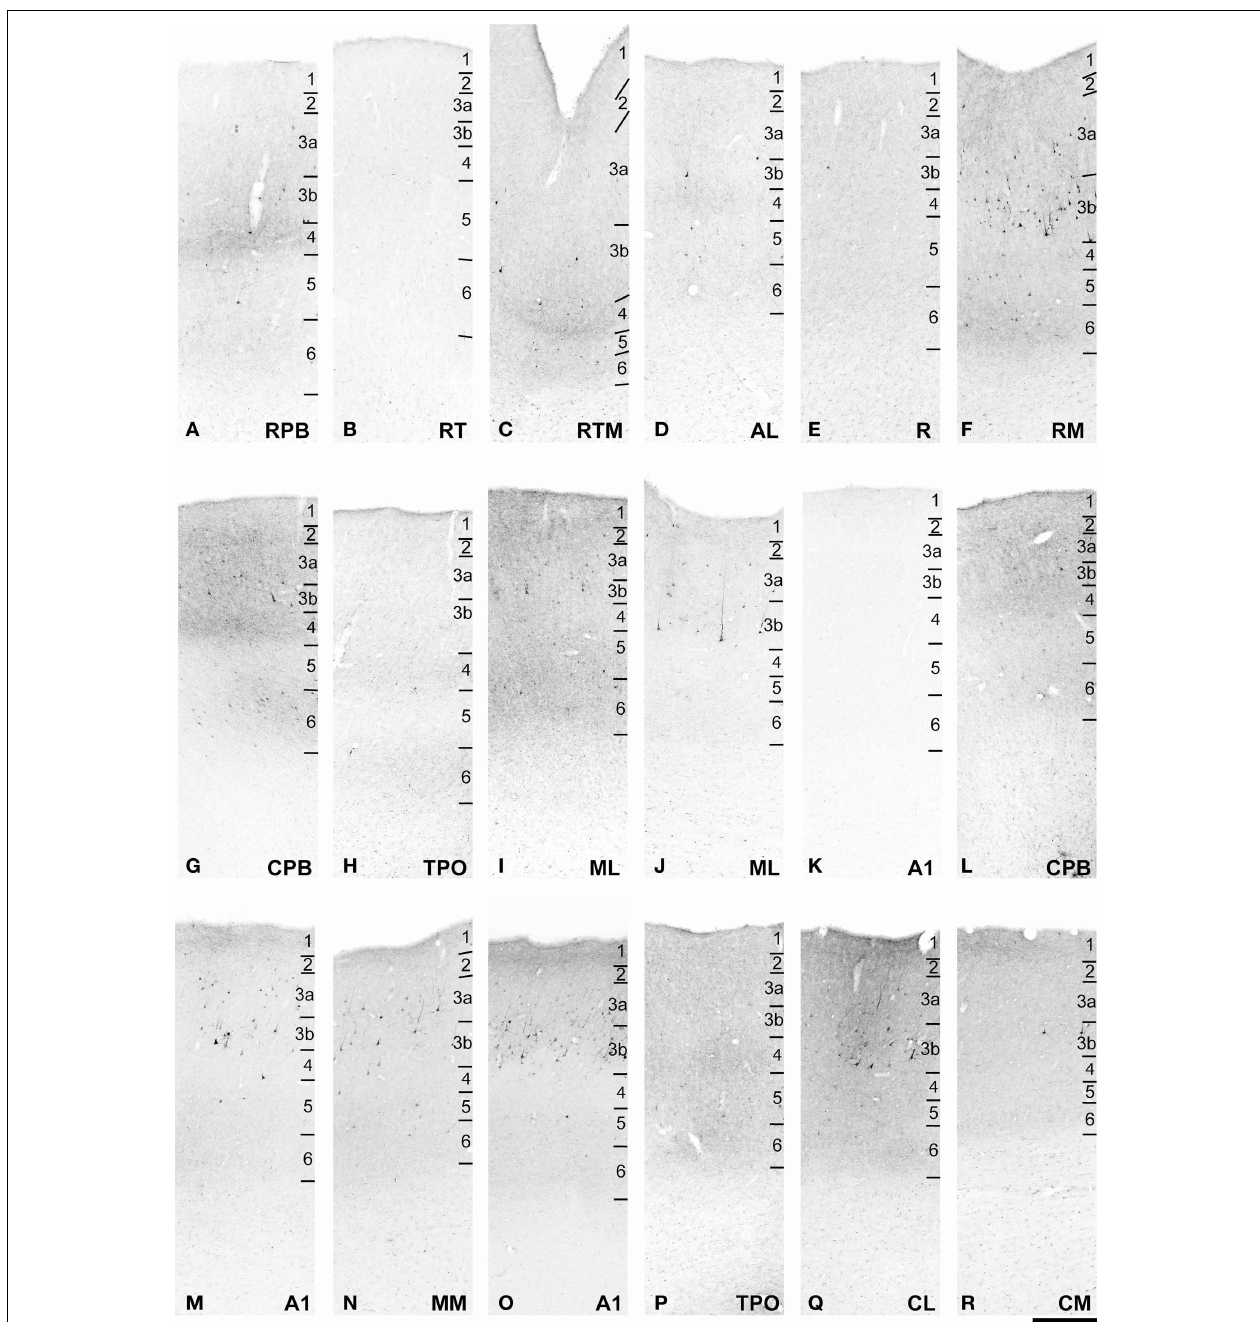
FIGURE 5 | FR labeling of areas corresponding to rectangular selections in Figure 4. (A–K) from (A–D) in Figure 4 . (L–R) from (E–H) in Figure 4 . See text for detailed descriptions and Figure 10 for graphical summary of these data. Scale, 500 µ m.